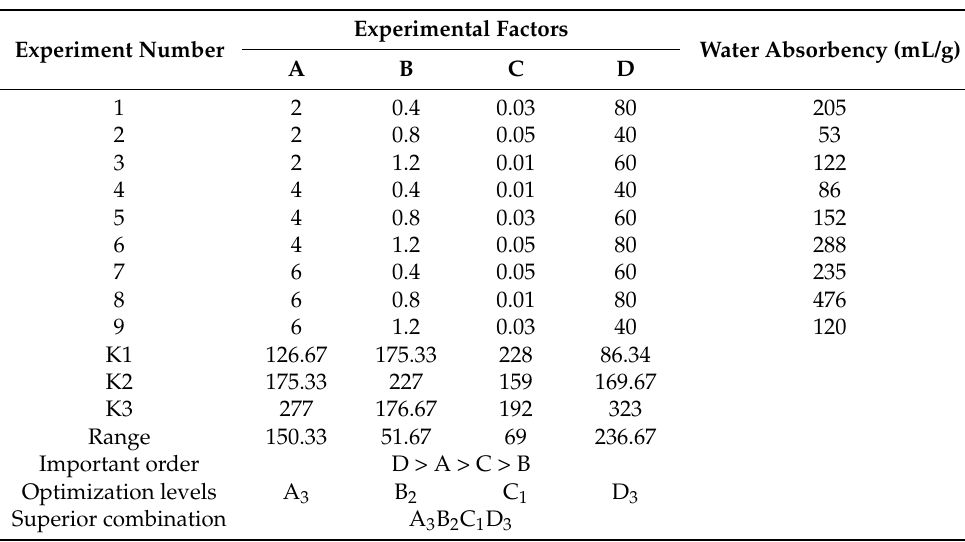
Table 3. Analysis of orthogonal experimental results for synthesis of superabsorbent